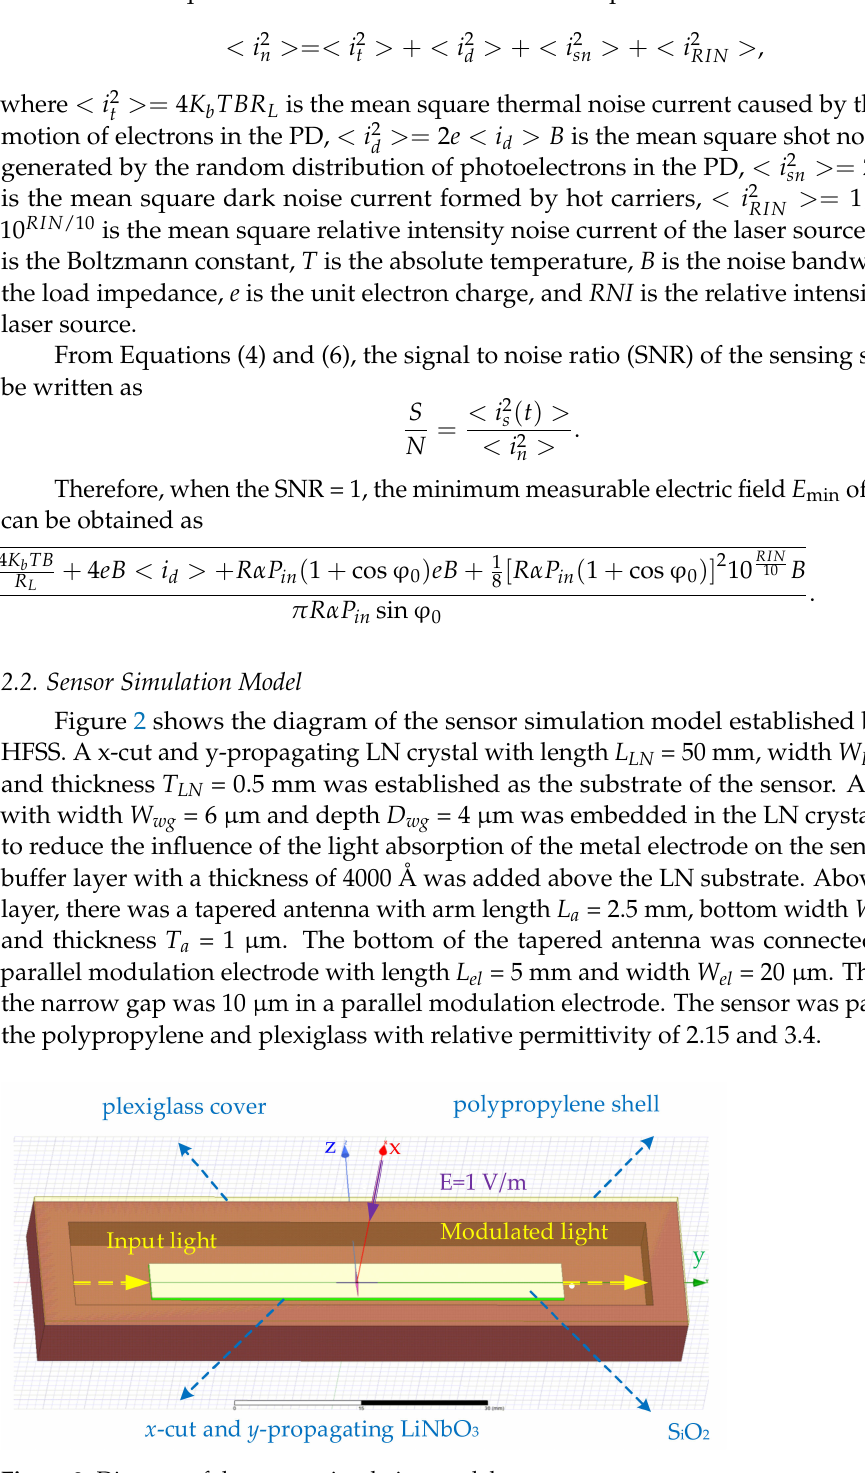
Figure 2. Diagram of the sensor simulation